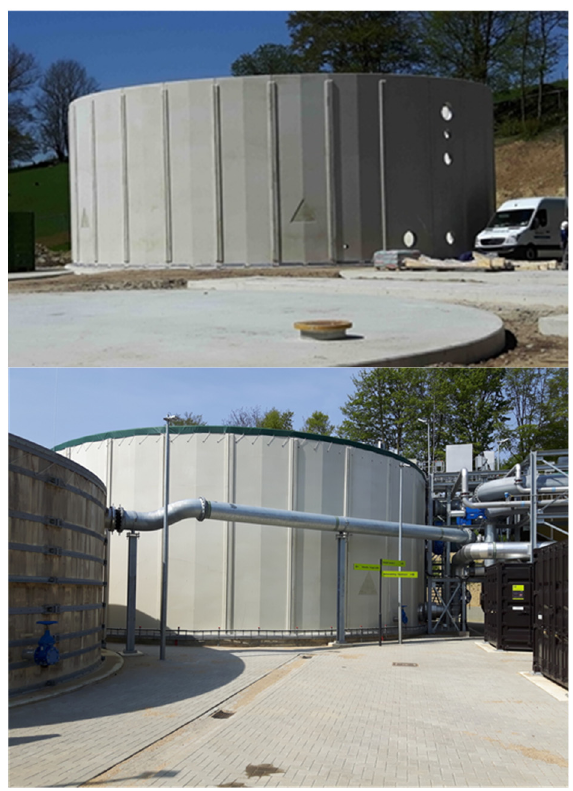
Figure 7. Prefabricated wastewater treatment tank under construction (top image) and in service (bottom image). Prefab elements bearing the triangular logo contain self ‐ healing agent while the other, reference elements, do